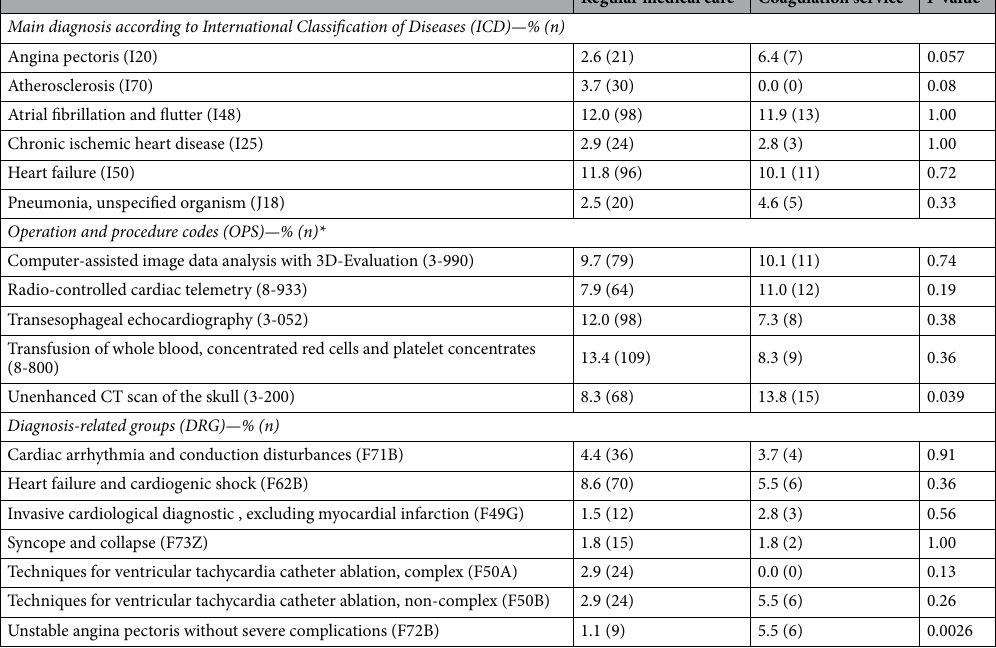
Table 2. Event classifications according to healthcare model. Operation and procedure codes (OPS) are presented according to the German procedure classification; five most common ICD, OPS and DRGs of each cohort are presented. The shown percentages are based on the number of events in each cohort. *Multiple designations are possible for one hospitalisation (i.e. there can be multiple OPS per event. The percentages for OPS are based on number of procedures per total